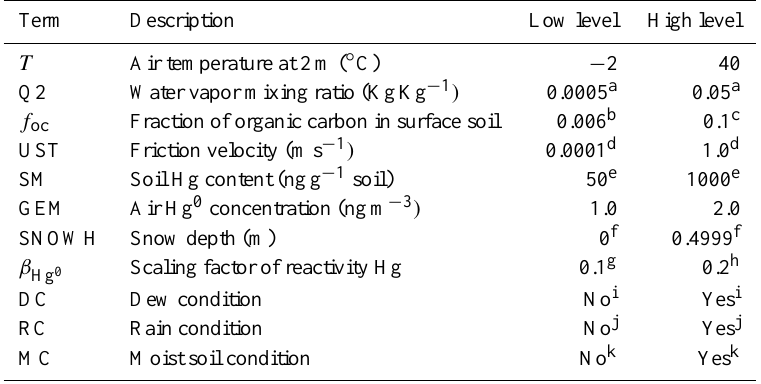
Table 3. Examined model variables and the experimental levels of factorial design for air–soil exchange over sparsely vegetated land, bare ground tundra and snow/ice surfaces.